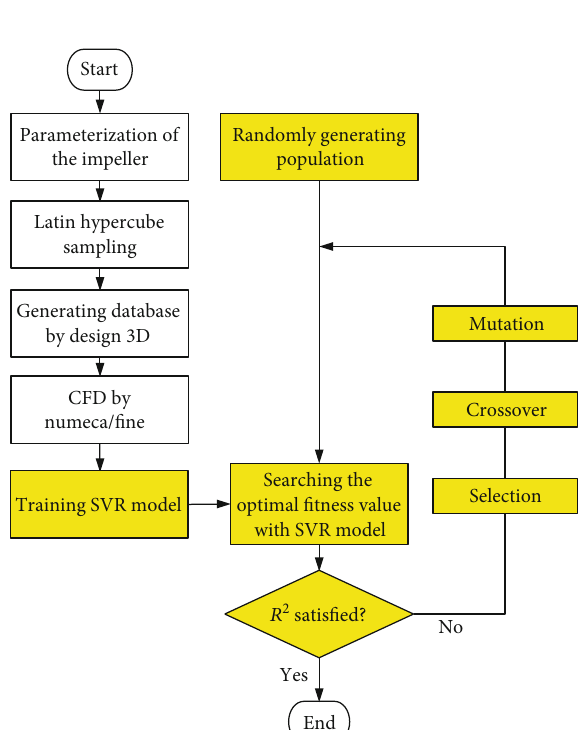
Figure 5: The basic fl owchart of the optimization